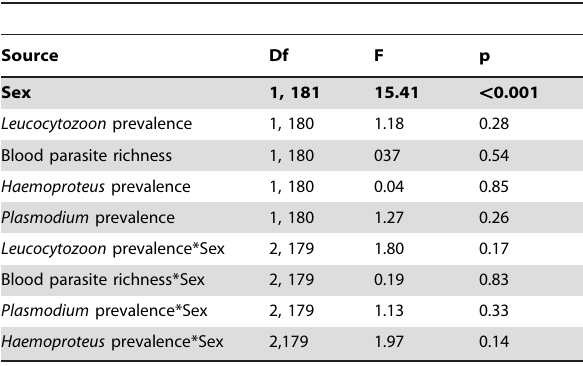
Table 1. Relationships between migration time and blood parasite prevalence and richness.